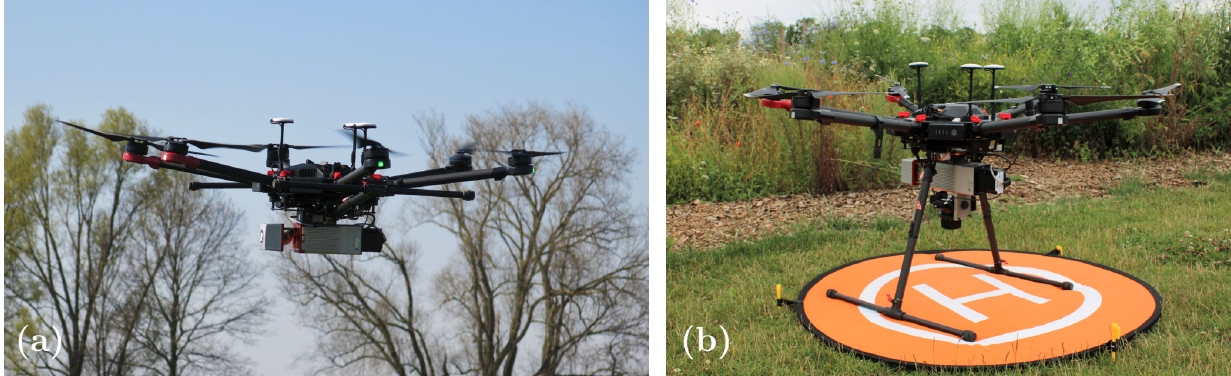
Figure 2. DJI Matrice 600 platform with the RIEGL miniVUX-2UAV laser scanner in flight ( a ) and on the ground ( b